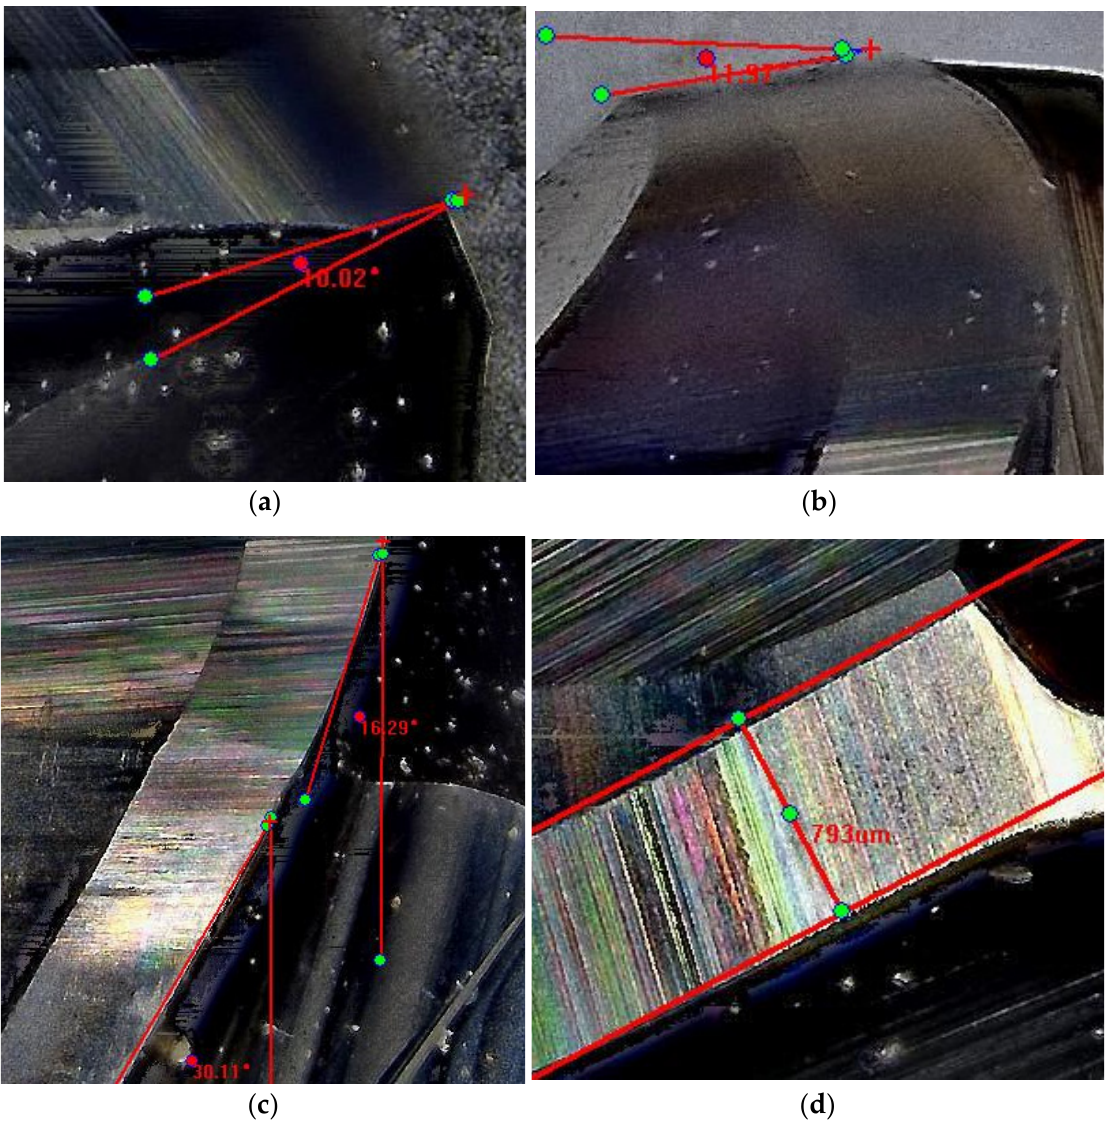
Figure 13. Geometric parameters detection results of DACT: ( a ) rake angle of DACT; ( b ) relief angle of DACT; ( c ) spiral angle of DACT; ( d ) flank face width of DACT.